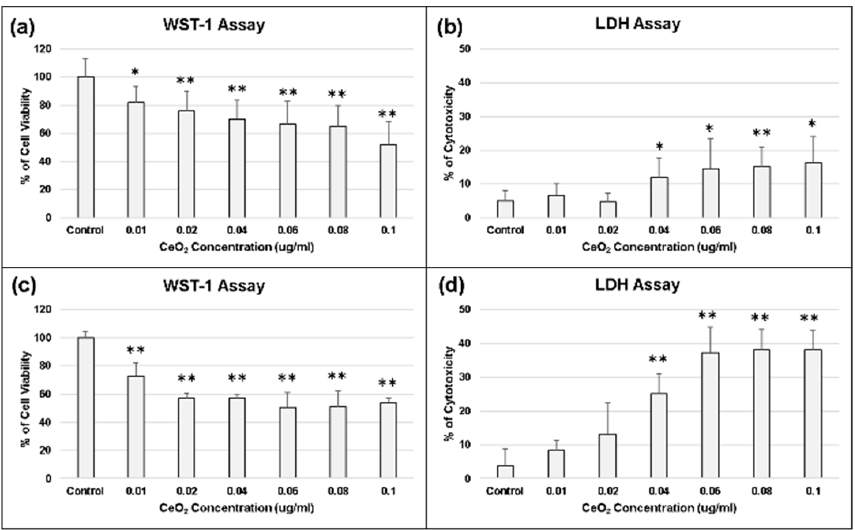
Figure 5. Biocompatibility of CeO 2 nanoparticles. ( a ) WST-1 assay on day 1; ( b ) LDH assay on day 1;